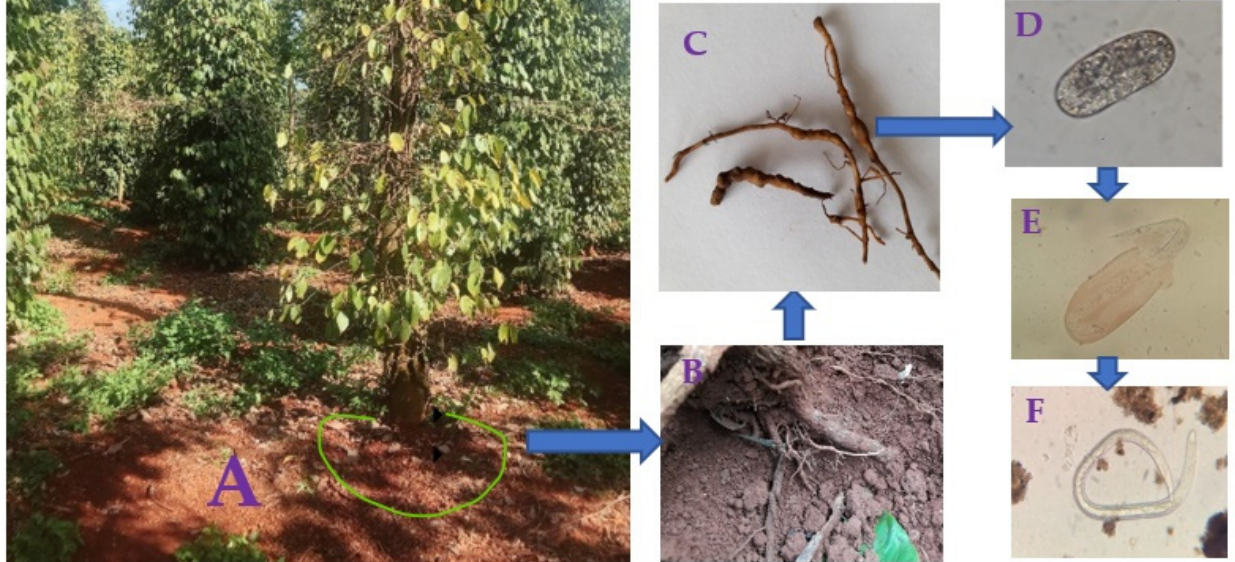
Figure 1. The process of preparation of eggs and root-knot nematodes ( J2 ) from black pepper roots. The black pepper with yellow leaves showing the symptom of nematodes infection ( A ) was chosen for collecting the roots ( B ). The roots with knots ( C ) was used for isolation of eggs ( D ) which were further incubated for 3–5 days for eggs hatching ( E ) to obtain J2 nematodes ( F ).